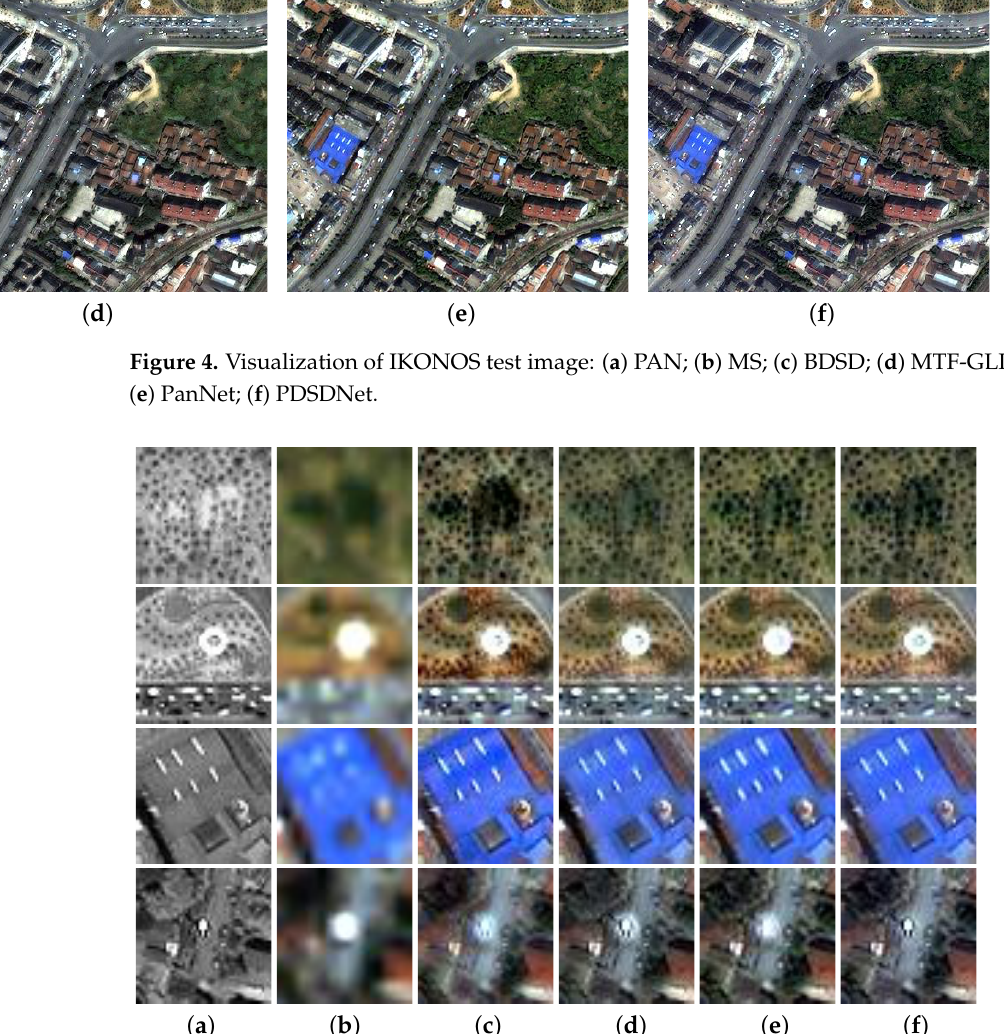
Figure 5. Visualization of local details of IKONOS test image: ( a ) PAN; ( b ) MS; ( c ) BDSD; ( d ) MTF- GLP-HPM-PP; ( e ) PanNet; ( f )